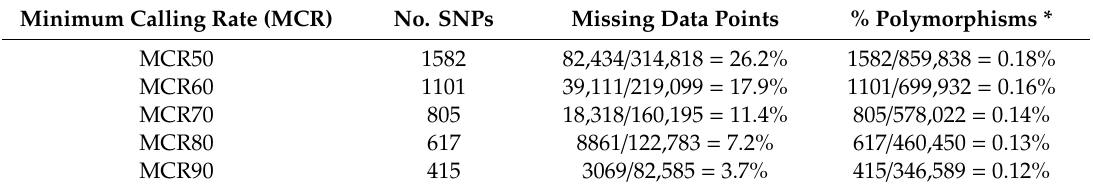
Table 1. Single nucleotide polymorphisms (SNP) genotyping summary. MCR50 was selected as